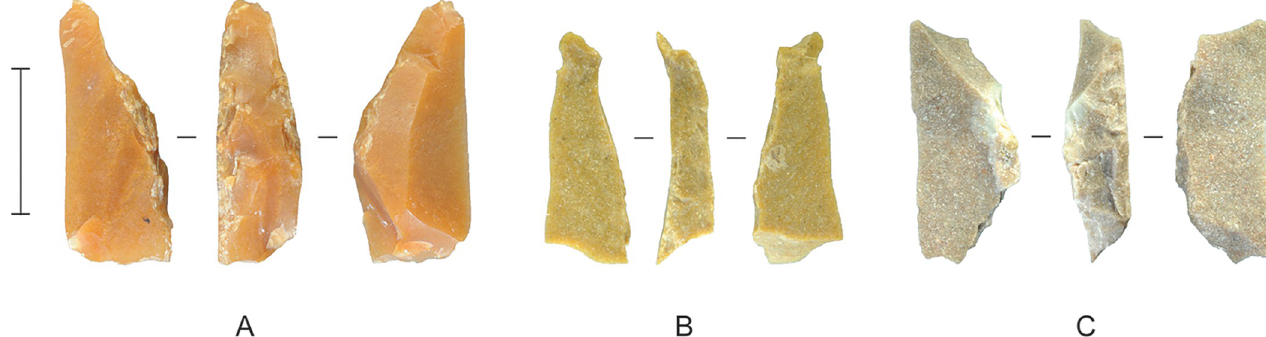
Fig 26. Microliths abandoned during the early phase of microlith manufacture, Horizon IV, Saruq al-Hadid. (A) Thick chert microlith with crushed platform edges and step-terminated flake scars on the backed face. The proximal end was detached by a single blow. (B) Chert microlith broken transversely across the proximal end, probably by a backing blow delivered without proper support. (C) Chert microlith with the distal end removed by a backing blow which propagated invasively and expanded laterally, rather than terminating at the anvil support. The lateral expansion lopped off the end of the microlith. From contexts 2023 (A), 2054 (B), and 2018 (C). Scale bar 10 mm.